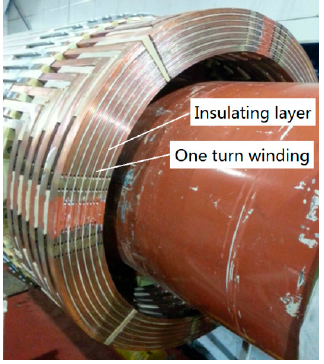
Figure 1. End structure of the excitation winding.